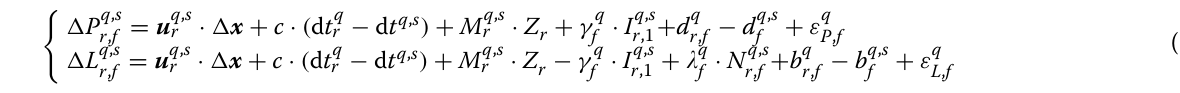
Methodology Ambiguity‑float